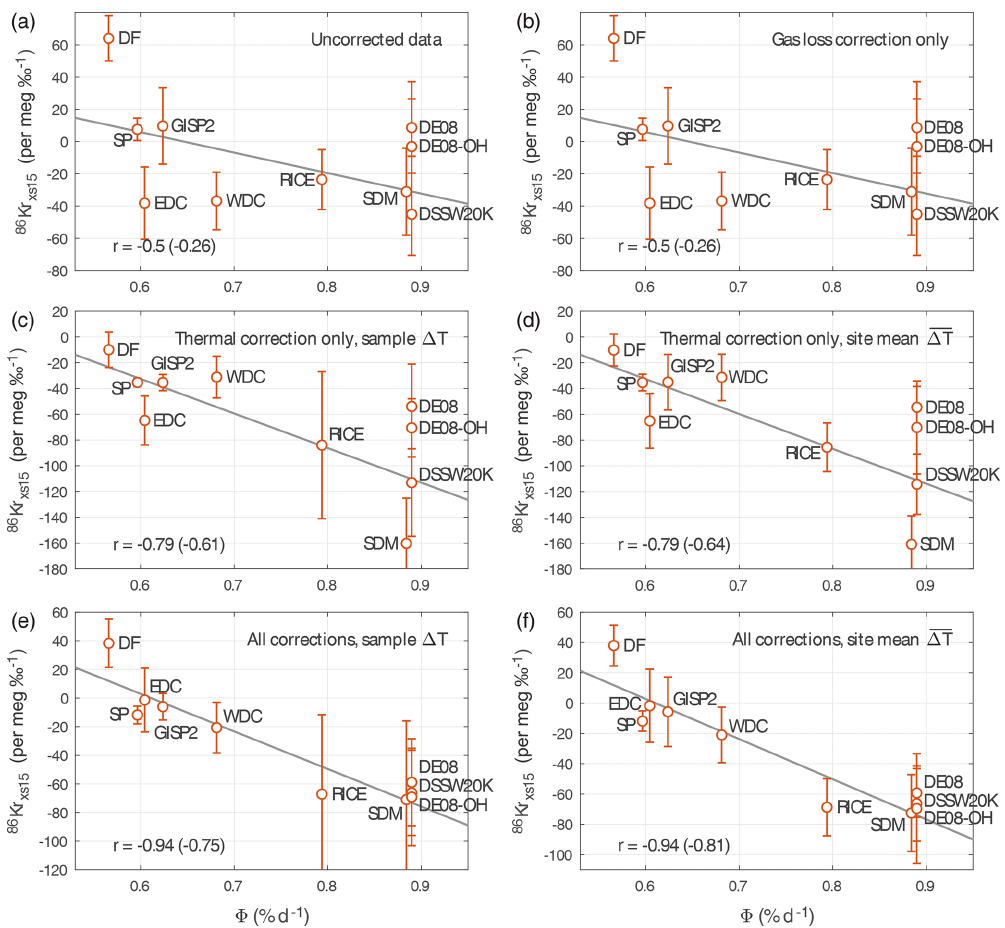
Figure A4. Same as Fig. A3, but for 86 Kr xs15 . Note that the gas loss correction (b) does not impact 86 Kr xs15 . For all correlations p < 0 . 05, except for panels (a) and (b) for which p = 0 . 16 for the site average